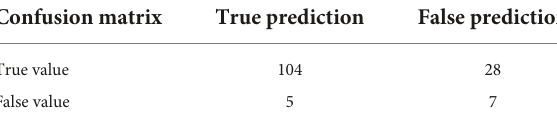
TABLE 5 Confusion matrix for the in-house validation